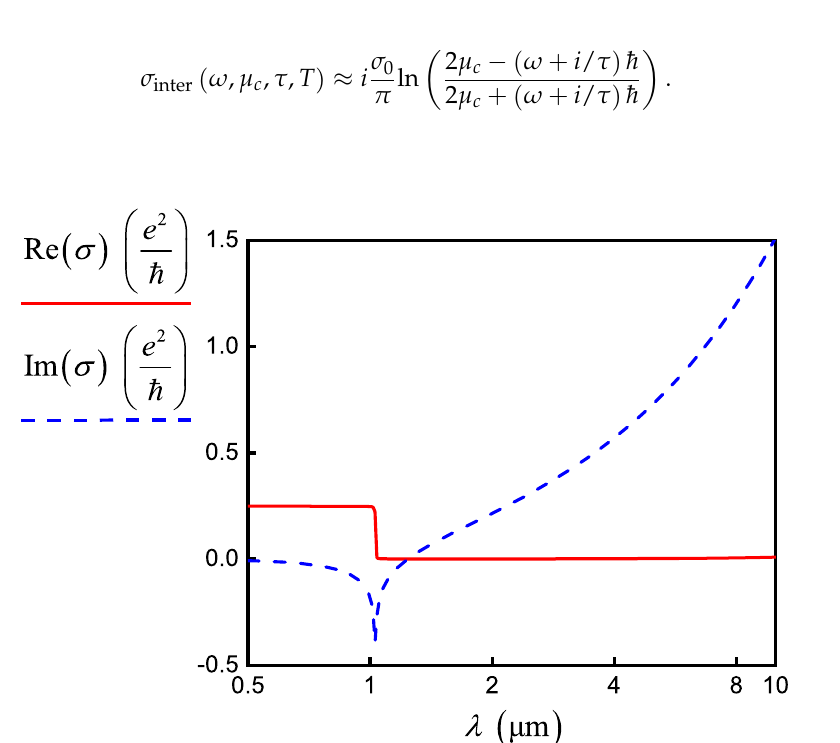
Figure 1. Real (solid red curve) and imaginary (dashed blue curve) parts of the conductivity of doped graphene with µ c = 0.6 eV, τ = 0.9 ps.